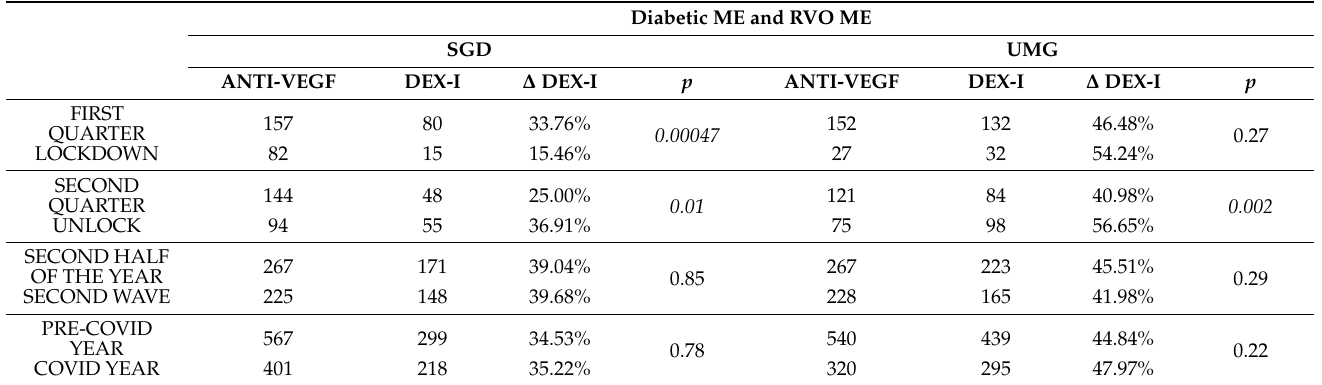
Table 3. Comparison of anti-VEGF and sustained-release dexamethasone intravitreal implant (DEX-I) treatment for diabetic macular edema (diabetic ME) and macular edema secondary to retinal vein occlusion (RVO ME). Note: statistically significant values are in